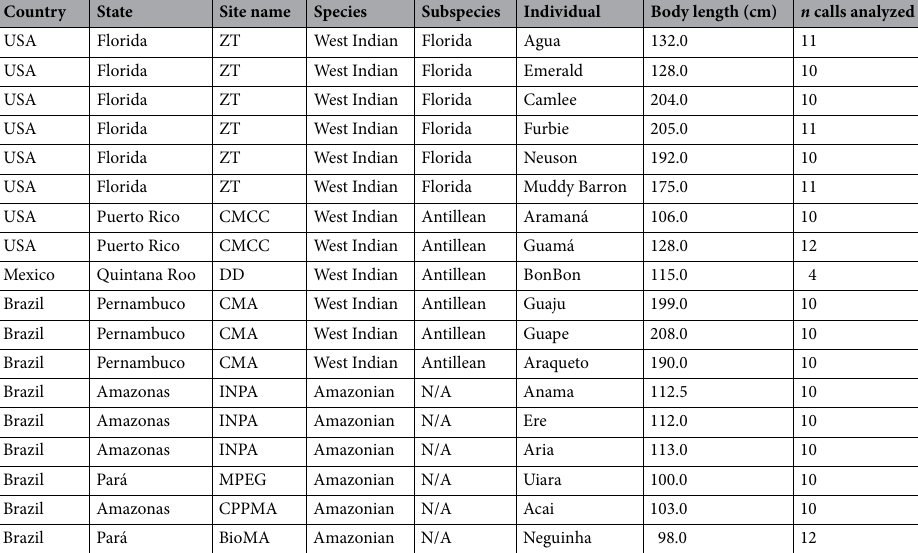
Table 1. Information on the manatee calves recorded in this study. The body length of each calf was measured during routine veterinary procedures according to standard protocols at each facility 38 ( ZT ZooTampa, CMCC Caribbean Manatee Conservation Center, DD Dolphin Discovery, CMA Centro Mamíferos Aquáticos/IBAMA, INPA Laboratório de Mamíferos Aquáticos of the Instituto Nacional de Pesquisas da Amazônia, MPEG Parque Zoobotânico of the Museu Paraense Emílio Goeldi, CPPMA Centro de Preservação e Pesquisa de Mamíferos Aquáticos da Manaus Energia, BioMA Biologia e Conservação de Mamíferos Aquáticos da